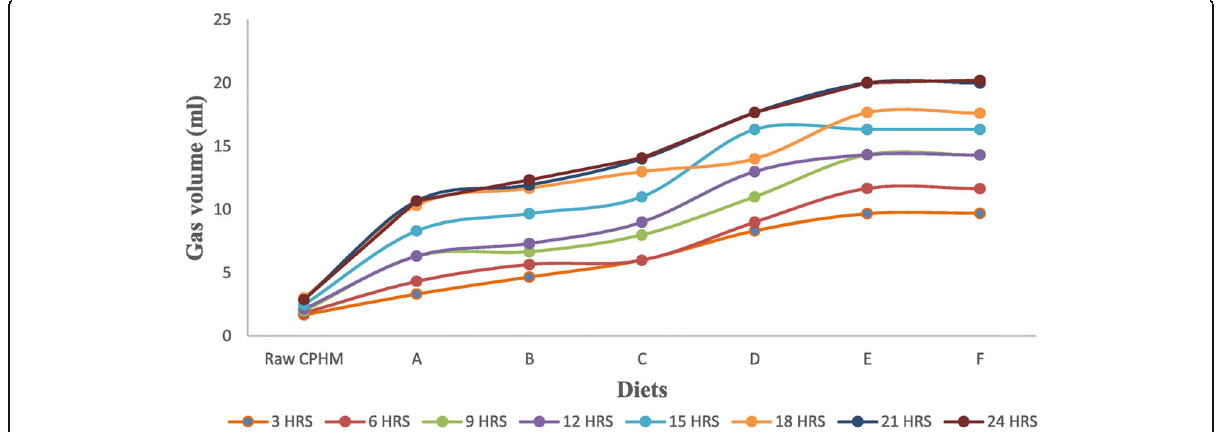
Fig. 1 Graphical representation of in vitro gas production of raw and replacement levels of urea-treated cocoa pod husk meal diets